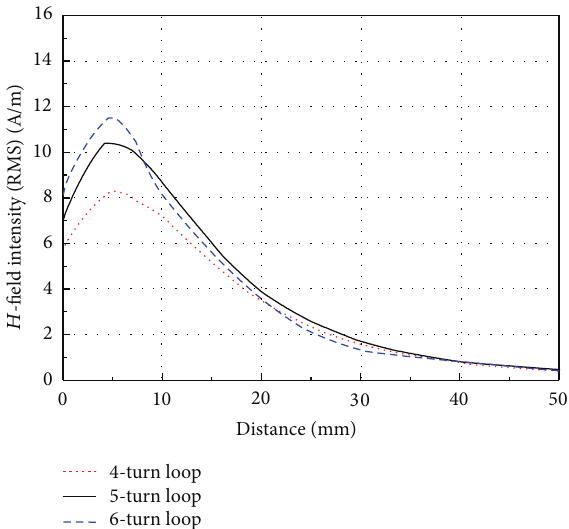
Figure 3: Simulated 𝐻 -field intensity along with a normal direction ( 𝑧 -axis) on the center of the loop antenna with varying number of the loop turns.